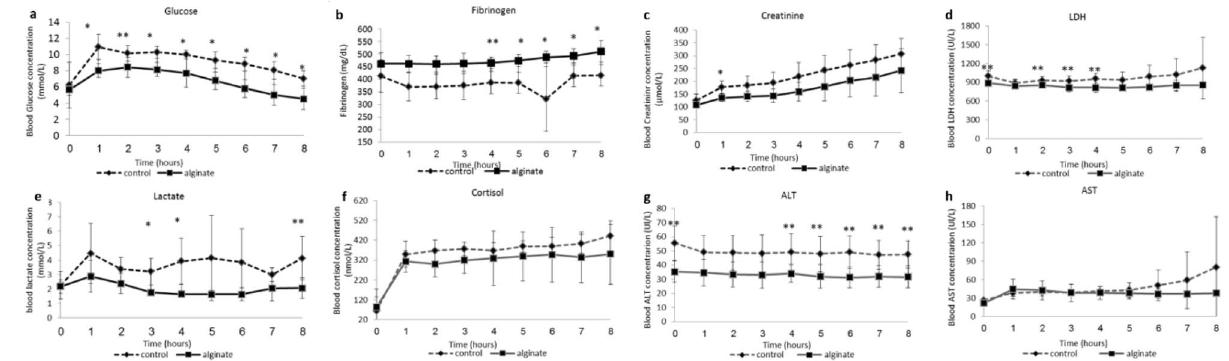
Figure 2. The effect of VLVG alginate on physiological parameters. ( a ) glucose, ( b ) fibrinogen, ( c ) Creatinine, ( d ) LDH, ( e ) Lactate, ( f ) Cortisol, ( g ) ALT, and ( h ) AST. Points are means ± SD deviation, n = 3 animals in the alginate group, n = 4 in the control group. * p < 0.05, ** p =